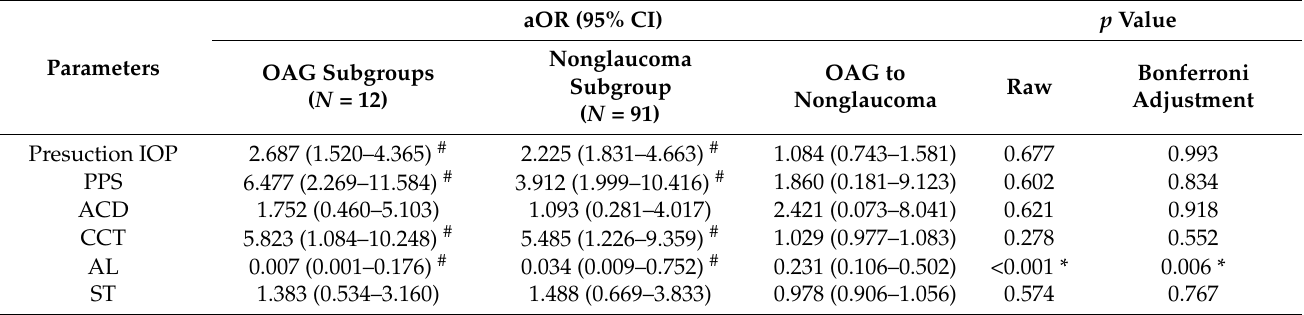
Table 3. Association of parameters with intraocular fluctuation during femtosecond laser-assisted cataract surgery in open-angle glaucoma compared to nonglaucoma